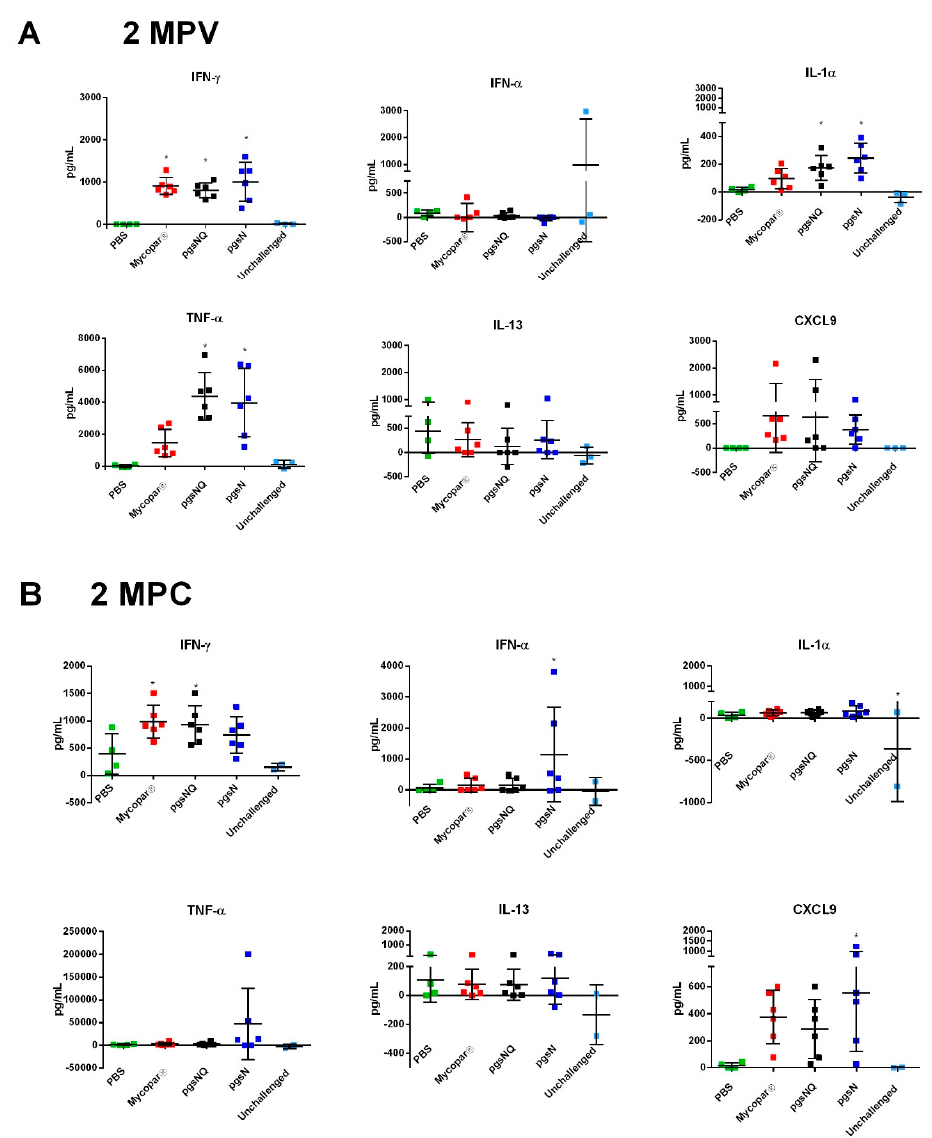
Figure 5. Protein array analysis of key cytokine levels in vaccinated calf groups. PBMC samples were isolated from whole blood and stimulated with Johnin PPD for 72 h. Cytokine levels in culture supernatants were determined using a bovine cytokine array kit at ( A ) 2-months post vaccination (MPV) and ( B ) 2-months post challenge (MPC). Data are expressed as mean with error bars representing standard deviation; *, p < 0.05 compared to the PBS group.